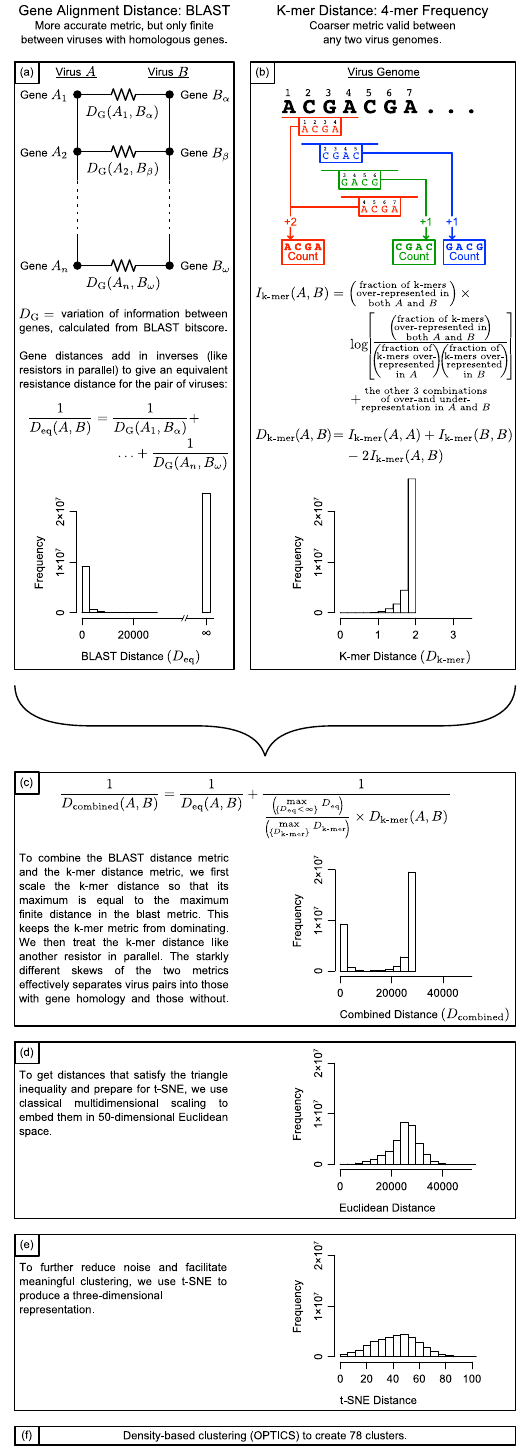
Fig 1. Graphical representation of workflow. (a) Each virus is made up of genes, some of which may match the genes on another virus (Viruses A and B, respectively). We imagine the variation of information between two genes D i as the resistance of a resistor connecting them. Then the total “distance” between the collections of genes in Viruses A and B is the equivalent resistance between the two sides. Only the genes A total number of options for choosing one gene from each virus is quite large, and most such choices do not yield a